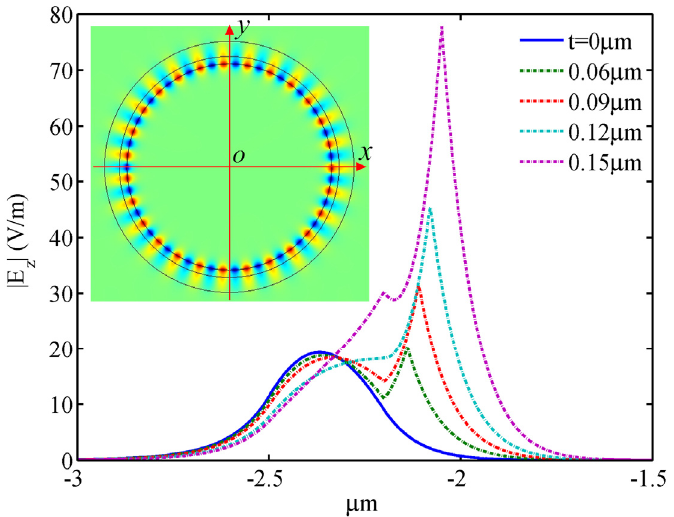
Figure 7. Electric field distribution along x axis from − 3 μ m to − 1.5 μ m for the NPM sensor operating in mode 27. The inset shows the electric field distribution of the NPM sensor, of which the NPM layer thickness is t = 0.15 μ